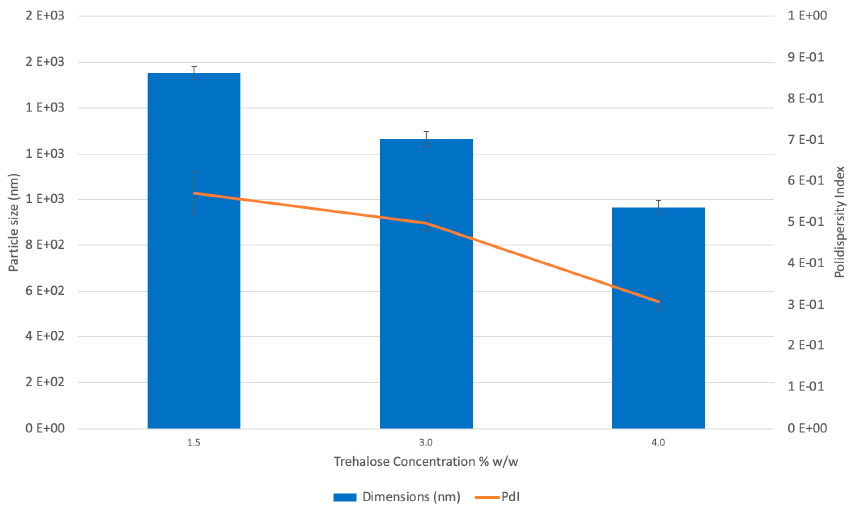
Figure 3. CH-MLC dimensions (nm) and polidispersity index (PdI) at different trehalose concen- trations: 1.5% w / w (batch CH-MLC 1), 3% w / w (batch CH-MLC 2) and 4% w / w (batch CH-MLC 3).